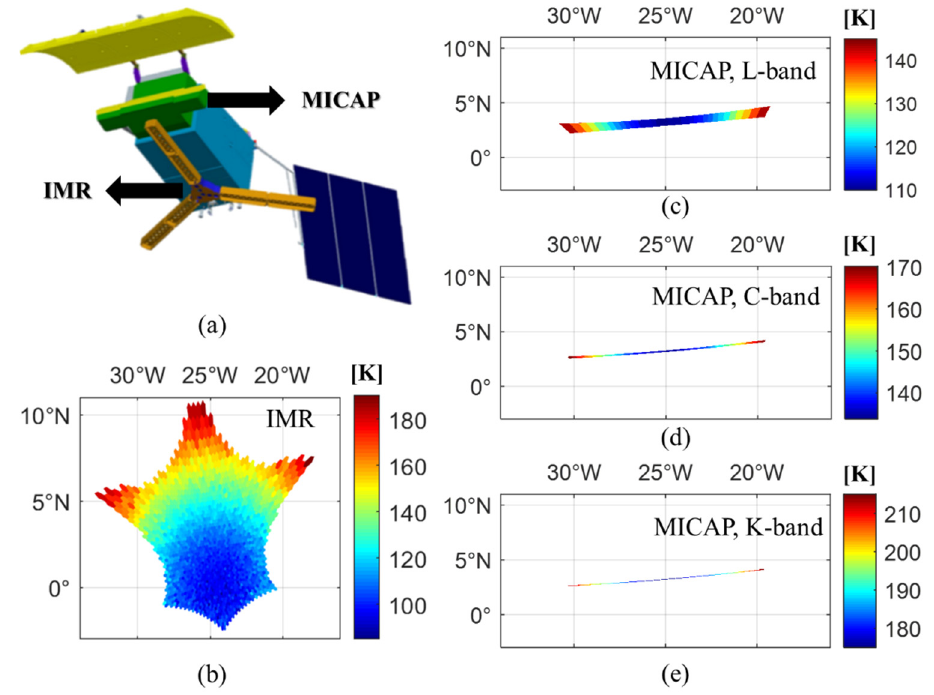
Figure 6. An illustration of ( a ) the design draft of payloads Interferometric Microwave Radiometer (IMR) and Microwave Imager Combined Active and Passive (MICAP) onboard the Chinese Salinity Satellite; ( b ) TB (Brightness Temperature) snapshot of IMR; ( c – e ) TB snapshots of MICAP L-, C-, K-band radiometers respectively.